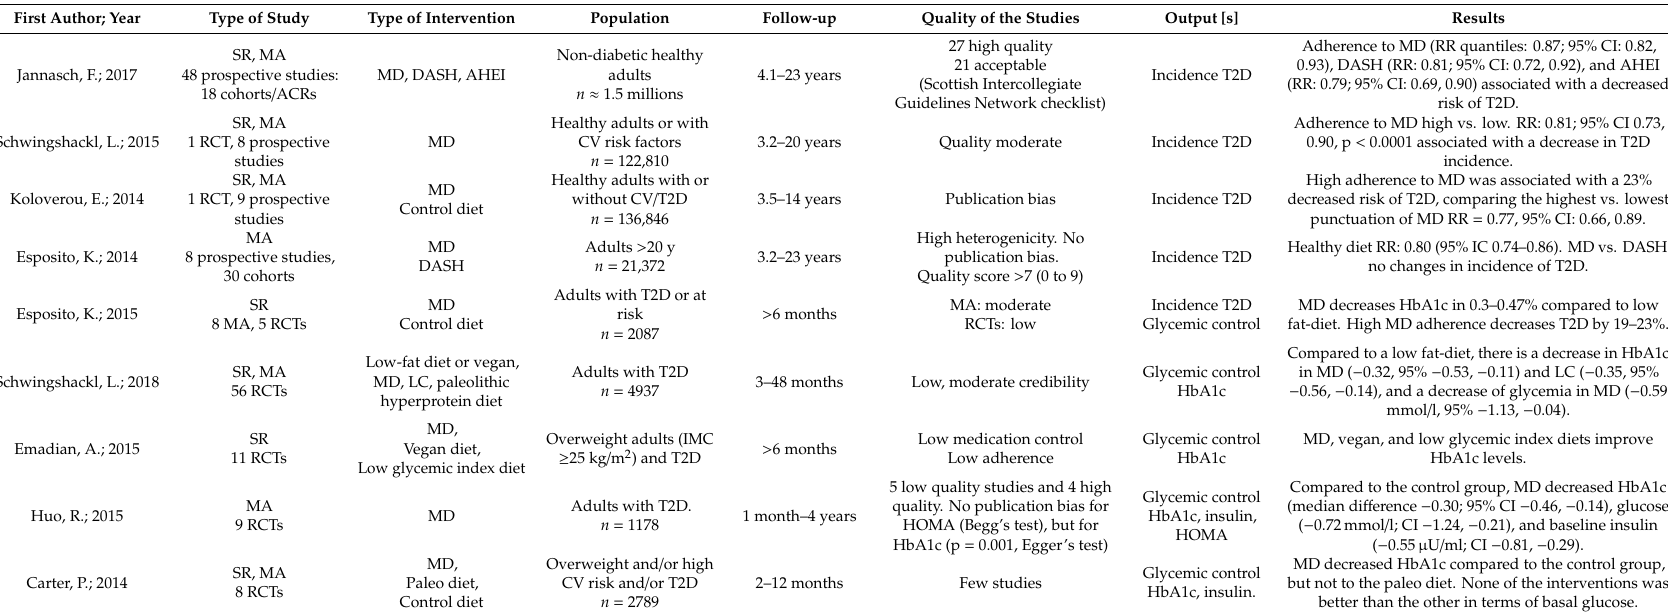
Table 1. Systematic reviews and meta-analysis of the association between Mediterranean diet and type 2 diabetes